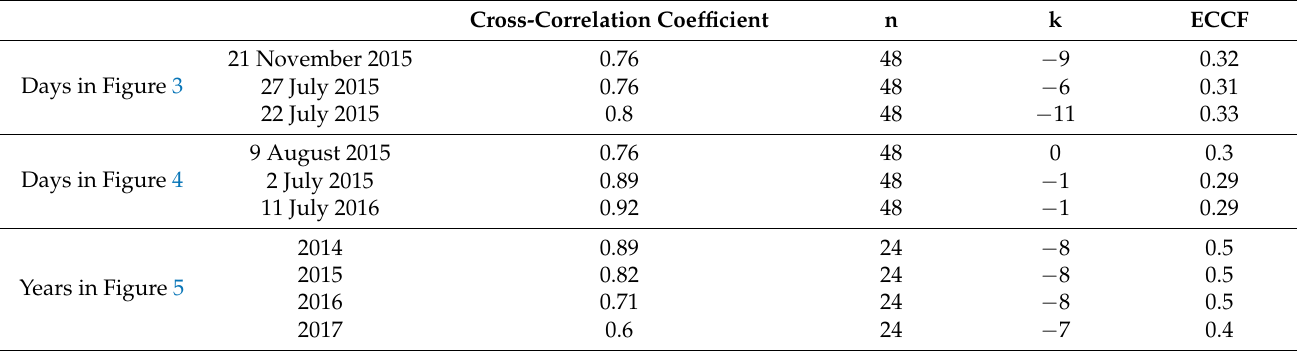
Table 2. Cross-correlation coefficient of days and years in Figures 3–5 and their ECCF. Cross-Correlation Coefficient n k